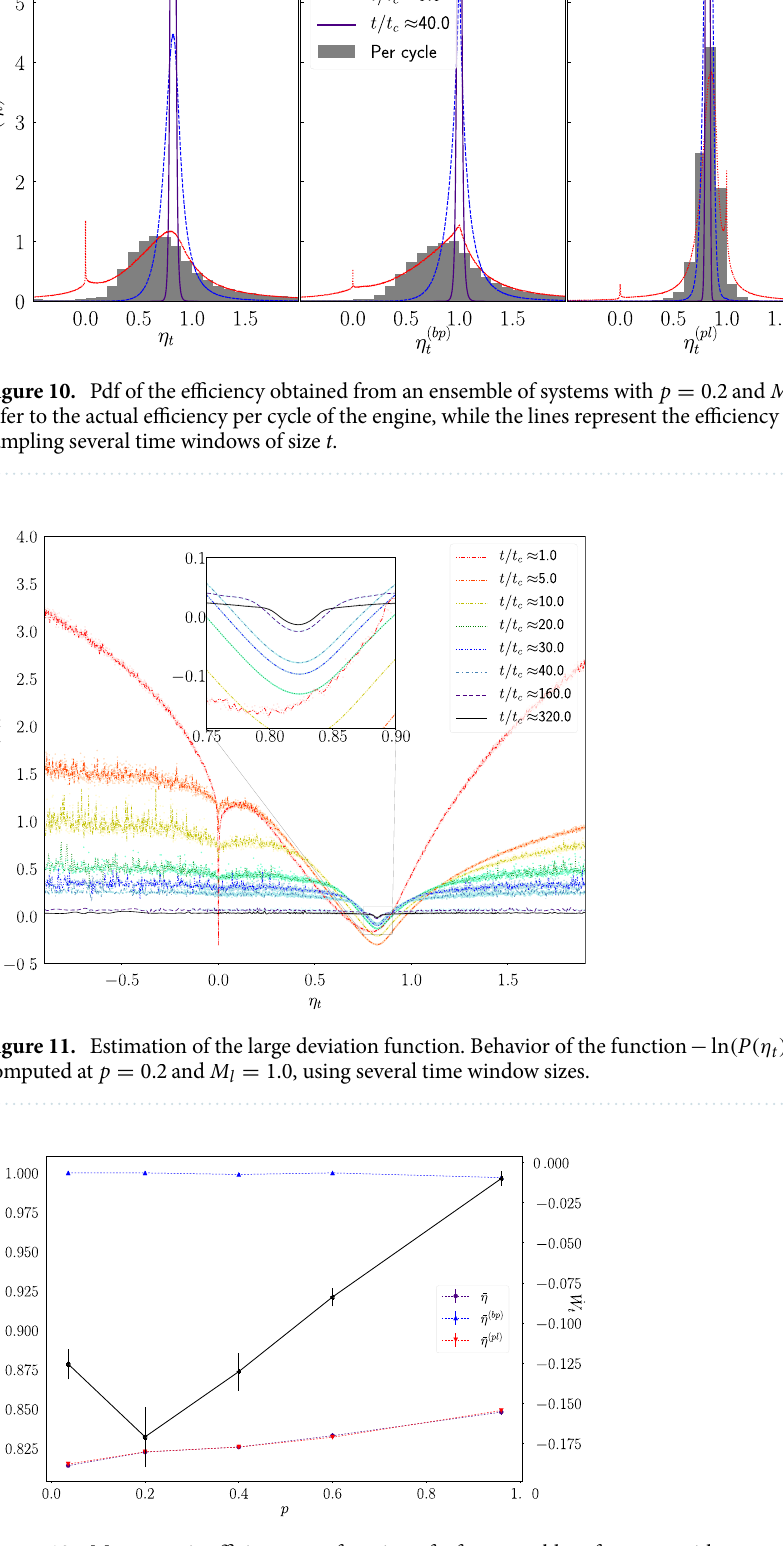
Figure 12. Macroscopic efficiency as a function of p for ensembles of systems with M l = 1 . The solid line plots the average power as a function of p using a time window of t = 320 ¯ t c (note the corresponding scale on the right side of the